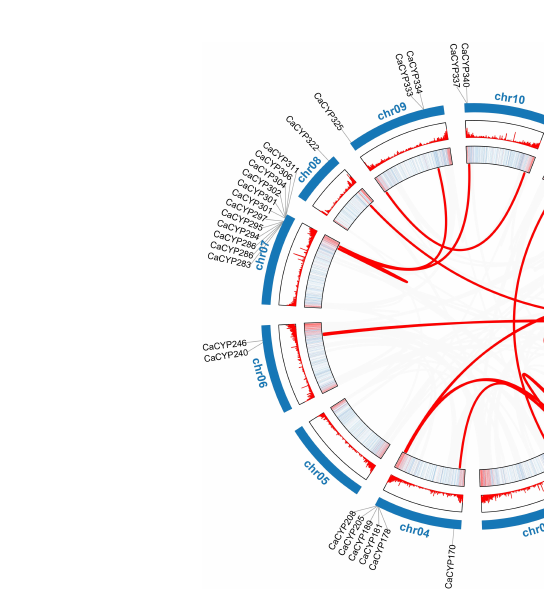
FIGURE 3 Collinearity analysis of the P450 family in pepper. The heatmap and lines represent gene density on the chromosomes. The CaCYP gene names of pepper were on the chromosomes. The gray lines in the background represent synteny blocks in the capsicum genome, while the red lines between chromosomes indicate segmental duplicated gene pairs.